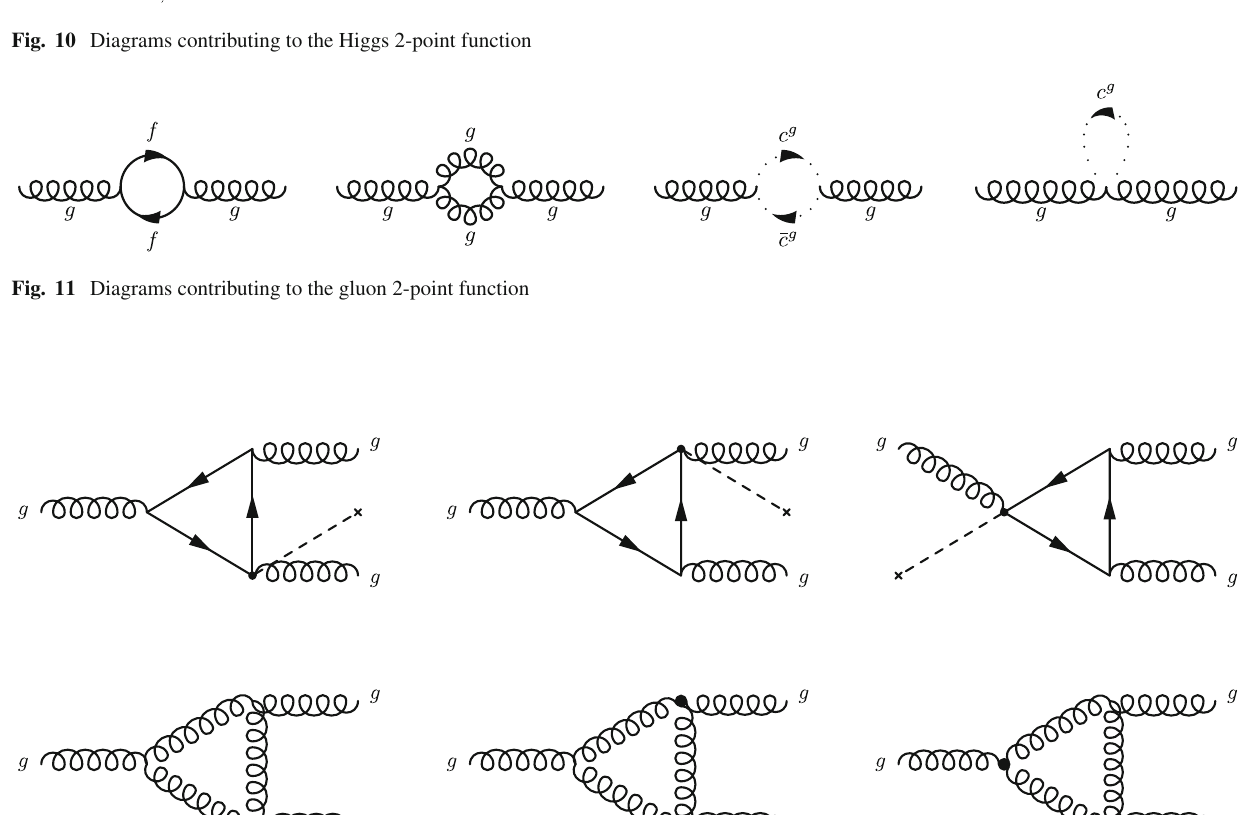
vanish, so we do not display them here. We also do not show diagrams with the external gluons attached to an SM vertex